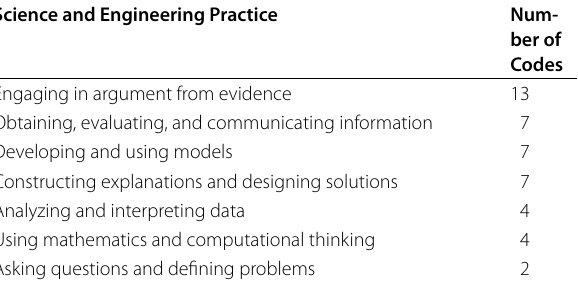
Fig. 3 Alignment Code Frequency (number of messages Table 4 Single SEPs used for Alignment in Practitioner Literature